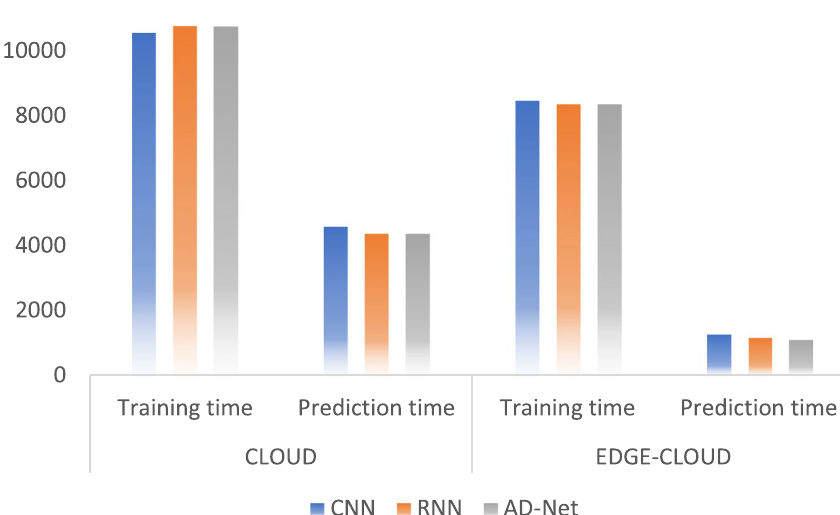
Fig. 10 Model training and prediction times using cloud and edge-cloud platform across various deep learning methods